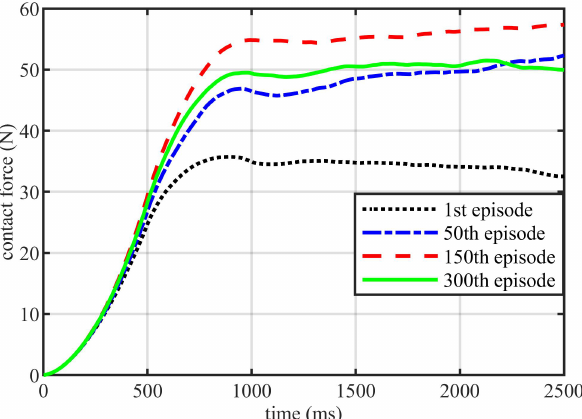
Figure 8. The contact force curves between the robot and the wall of different episodes. The obtained optimal trajectories are applied to the real KUKA IIWA robot in Figure 9 where the end effector is perpendicular to the wall. The optimal trajectory in Cartesian space was firstly converted into the trajectory in joint space by the inverse kinematics model of the KUKA IIWA robot, and then executed by the mature joint position controller of the robot at a frequency of 175 Hz.